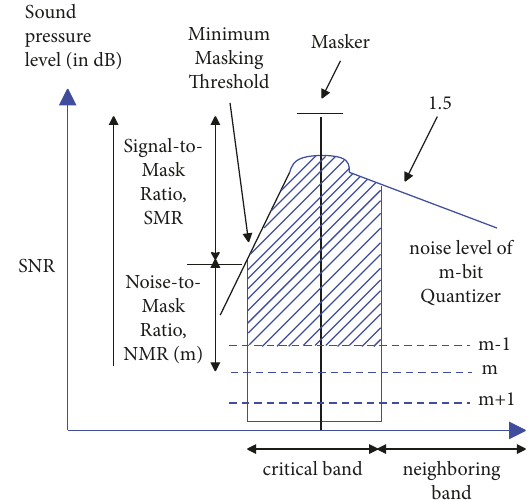
Figure 4: Demonstration of NMR(m) � SMR − SNR(m) (dB)